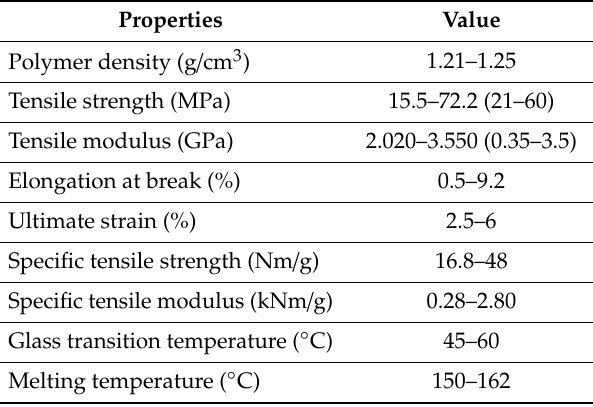
Table 1. Typical ranges of mechanical properties for Polylactic Acid (PLA) material using Fusion Deposition Modeling (FDM) technology